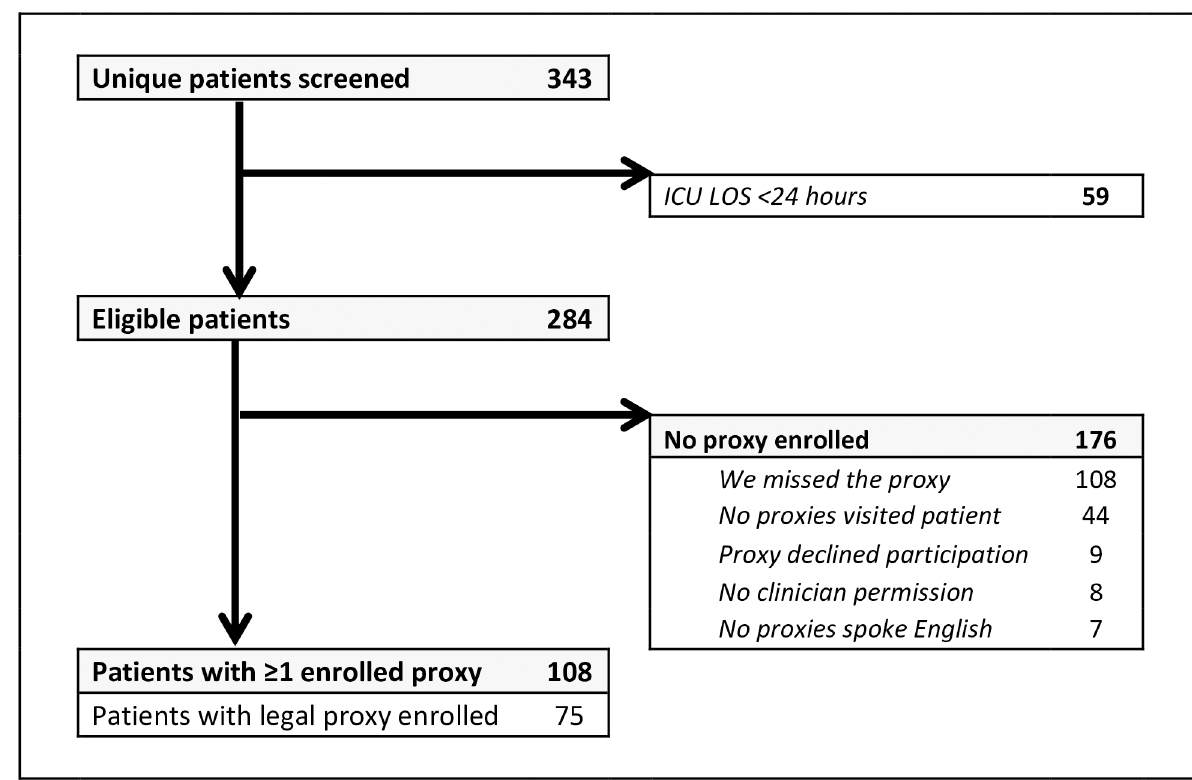
Fig 1. Patient screening, study eligibility and enrollment. 369 ICU admissionsfor 343 uniquepatients were screened. Only a patient’s 1st ICU admissionduringthe study periodwas analyzed.Eight patients had two proxiesenrolled.